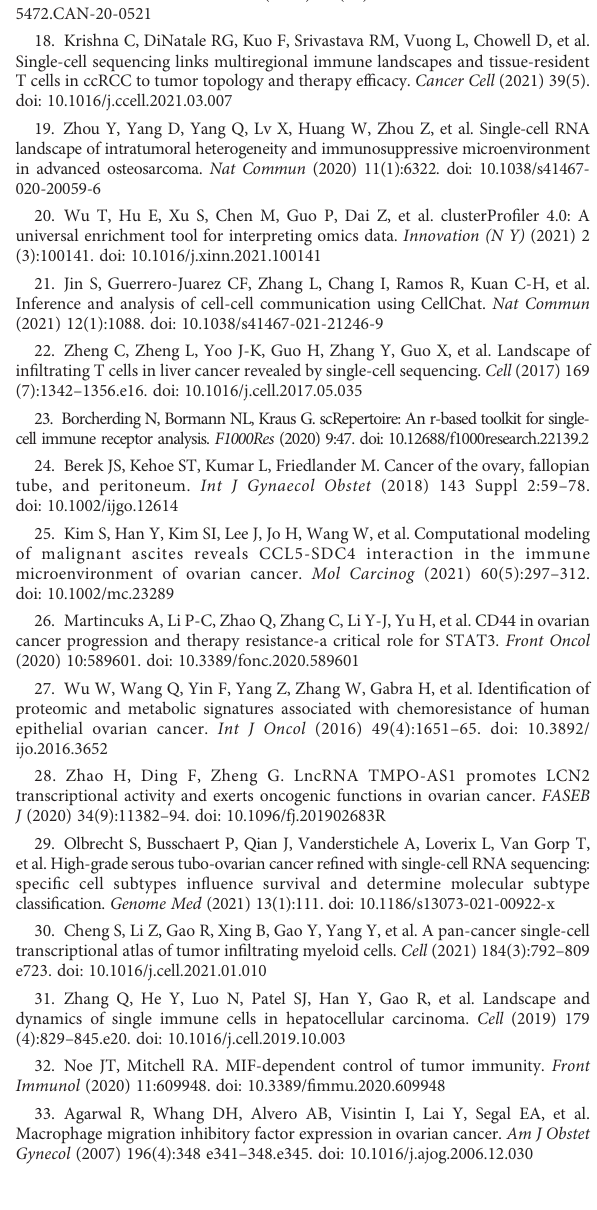
Dynamics of dominant CDR3 sequences of BCRs across samples pre and post chemotherapy, colored by types of dominant sequences. (D) Violin plots show distributions of CDR3 length of naïve B cells (left) and memory B cells(right) across samples pre and post chemotherapy. ( E and F ) Bar graphs show the fraction of immunoglobulin IGHV (upper left), IGHJ (upper right), IGLV/IGKV (bottom left), and IGLJ/IGKJ (bottom right) genes in naïve B cells (E) and memory B cells (F) . Genes with signi fi cant changes are labeled red. (*indicates a FDR < 0.01, ** indicates a FDR < 0.001, *** indicates a FDR < 0.0001, **** indicates a FDR < 0.00001). The results above are generated by comparison between samples ( blood_before, blood_after